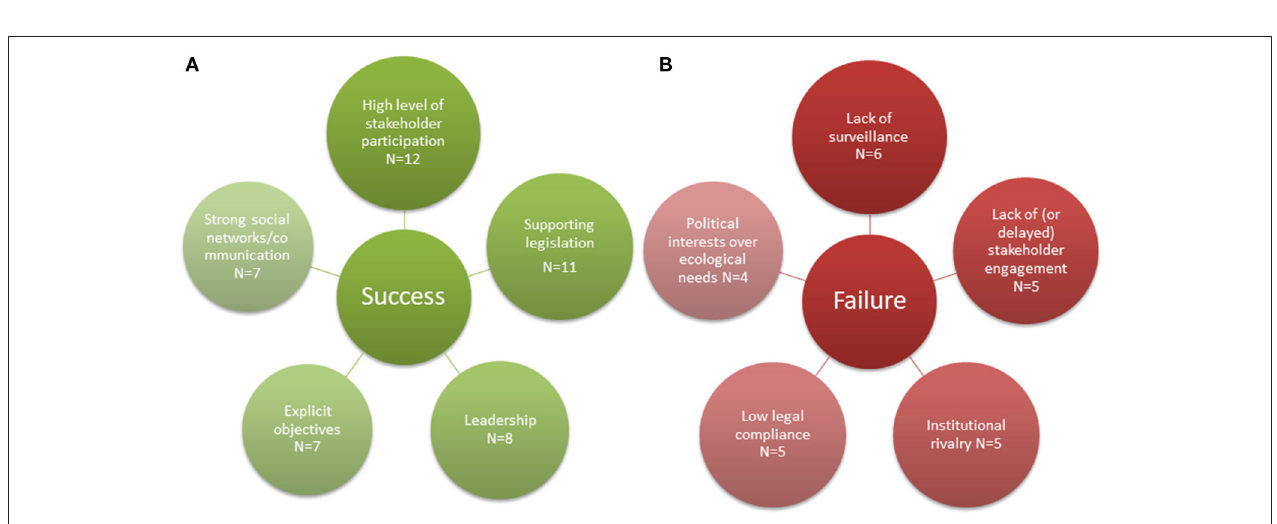
FIGURE 2 | Five top factors determining the (A) success of 16 and (B) failure of 11 MPAs across the world according to expert judgment.